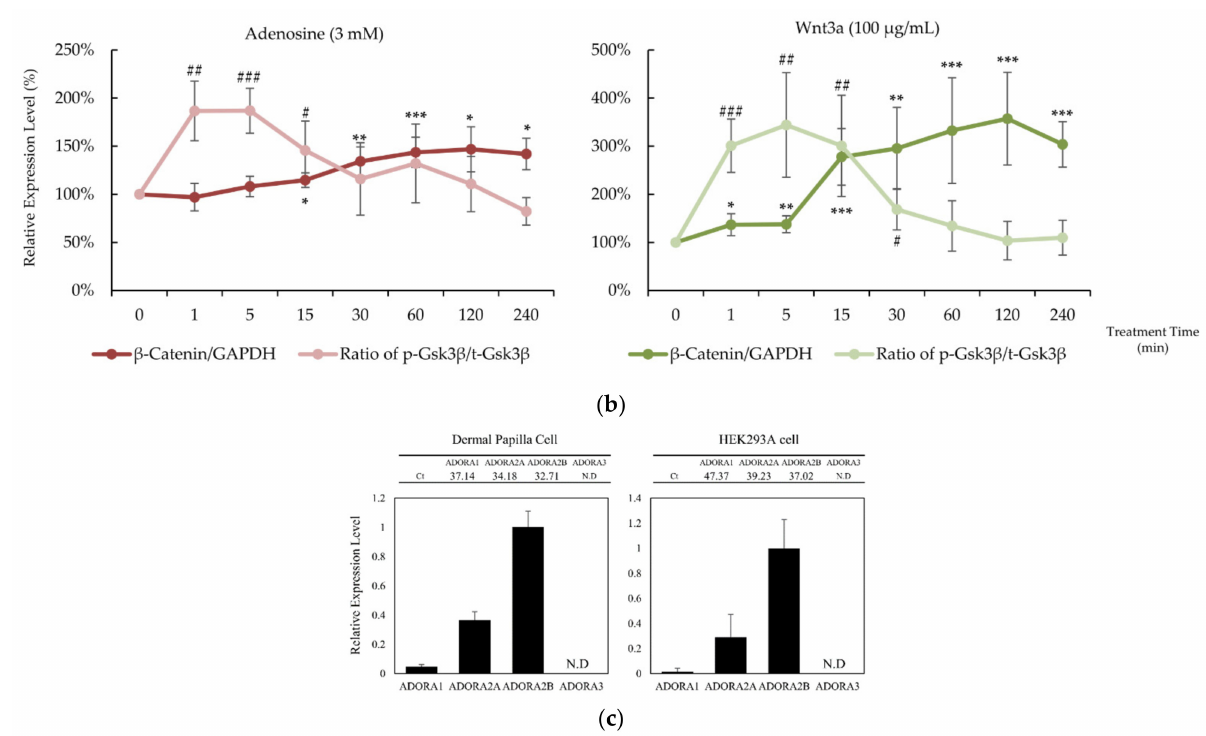
Figure 1. Adenosine activated Wnt/ β -catenin signaling pathway in human dermal papilla cells. Cells were treated with adenosine for different times (0, 1, 5, 15, 30, 60, 120, and 240 min). ( a ) Whole cell lysates were analyzed by immunoblotting to determine the levels of β -catenin, pS9-Gsk3 β , and Gsk3 β . As an internal control, GAPDH was used. ( b ) The expression level of β -catenin, normalized with GAPDH, and the ratio of phosphorylated Gsk3 β (Ser9) to total Gsk3 β protein were evaluated. Wnt3a (100 ng/mL) was used as a positive control. ( c ) The mRNA expression profiles of ADORA1, ADORA2A, ADORA2B, and ADORA3 were examined in cultured human dermal papilla cells and HEK293A reporter cells. The data represent the means of six independent samples. Significantly different compared with 0 min treatment samples ( β -Catenin * p < 0.05, ** p < 0.01, *** p < 0.001; ratio of pS9-Gsk3 β /total Gsk3 β (p-Gsk3 β /t-Gsk3 β ) # p < 0.05, ## p < 0.01, ### p <